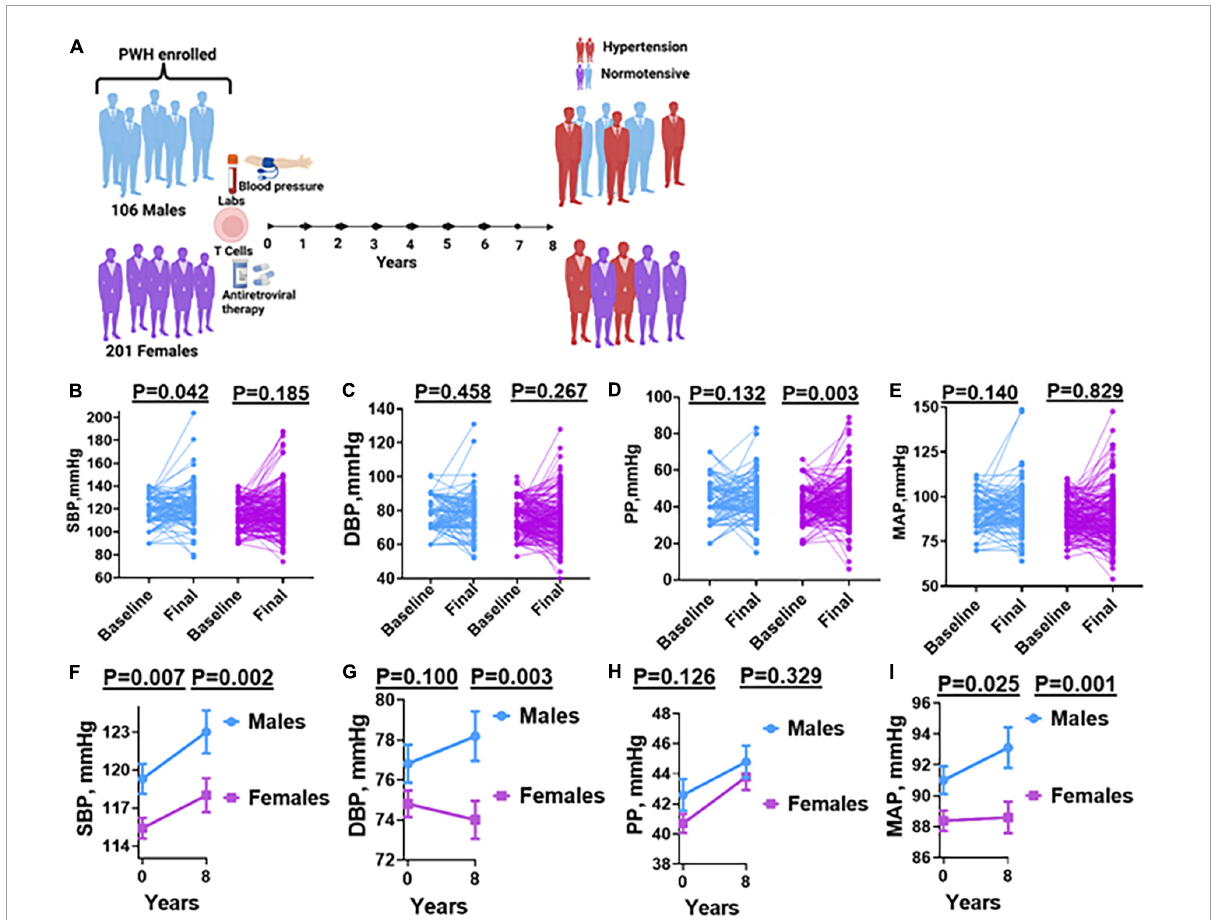
FIGURE1 Blood pressure measurements before and after antiretroviral therapy in males and females. (A) Schematic of experimental design. (B) SBP, (C) DBP, (D) PP, (E) MAP: shows changes in individual parameters at baseline and final (after antiretroviral therapy) in males and females. (F) SBP, (G) DBP, (H) PP, (I) MAP: shows composite means of each parameter at baseline and final (after antiretroviral therapy) in males and females. Wilcoxon matched-pairs signed rank test and paired t -test was used to determine the P -values. SBP, systolic blood pressure; DBP, diastolic blood pressure; PP, pulse pressure; MAP, mean arterial